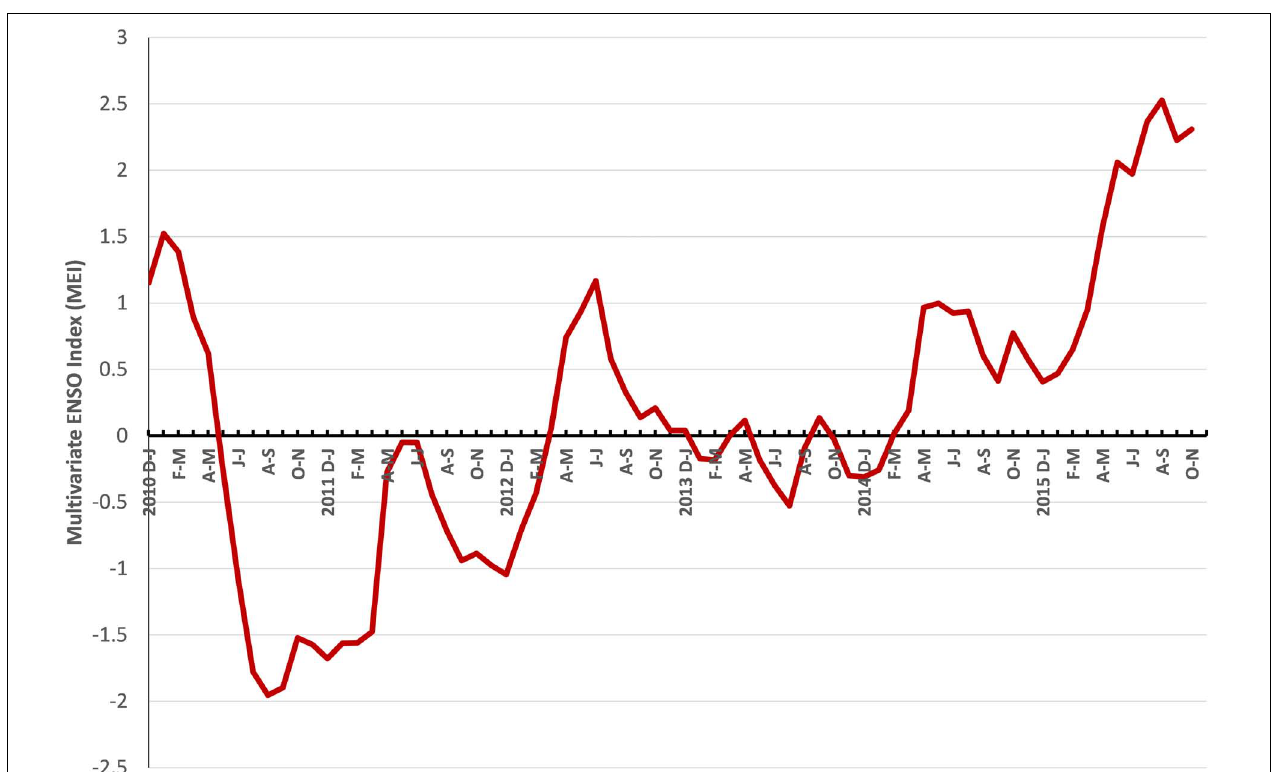
FIGURE 11 | Bimonthly multivariate ENSO index (MEI) values from 2010 to 2015.